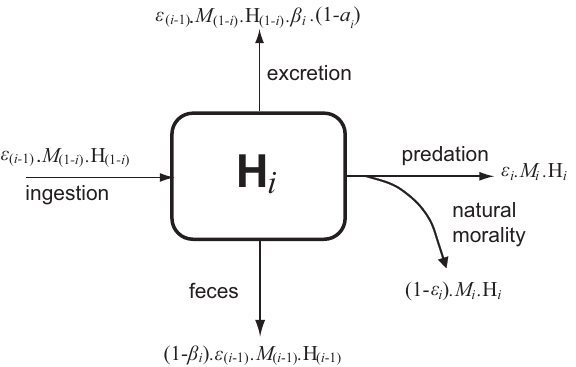
Fig. 2. Flow diagram for a trophic level i (H i ); ε i represents the pro- portion of the annual natural mortality rate ( M i ) which is associated to predation by the trophic level H (i + 1 ) ; β i represents the assimi- lation efficiency and (1 − β i ) represents the proportion of ingested food which is not incorporated into biomass; a i is the accumulation efficiency, and (1 − a i ) represents the fraction of nutrient excreted after